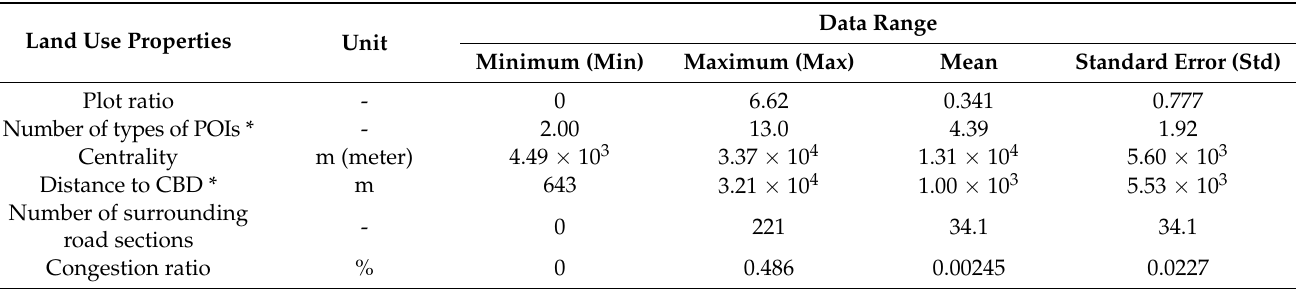
Table 1. The overview of the land use properties